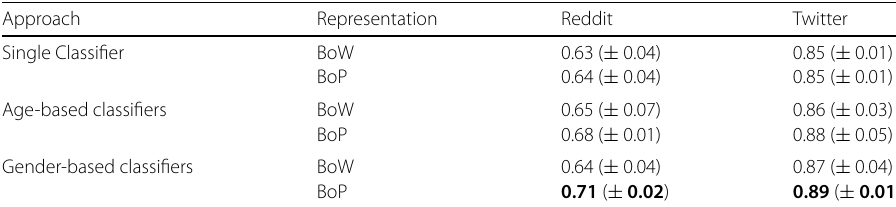
classifiers per users’ traits and the BoP representation Approach Representation